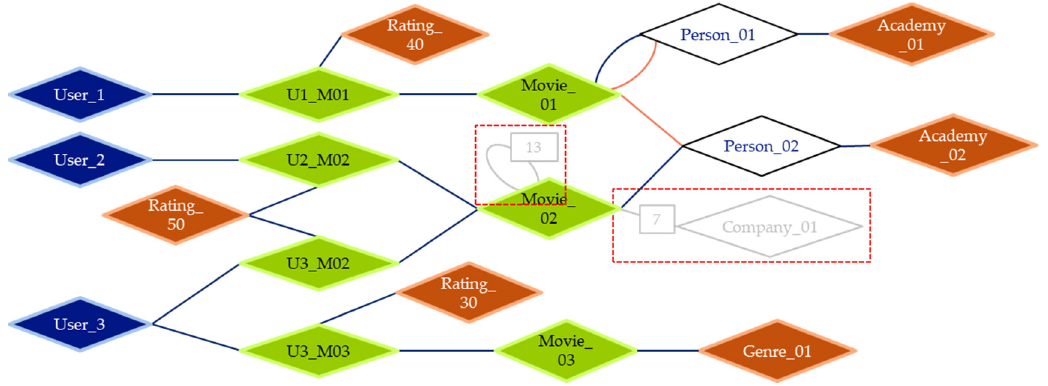
Figure 6. Instance graph.